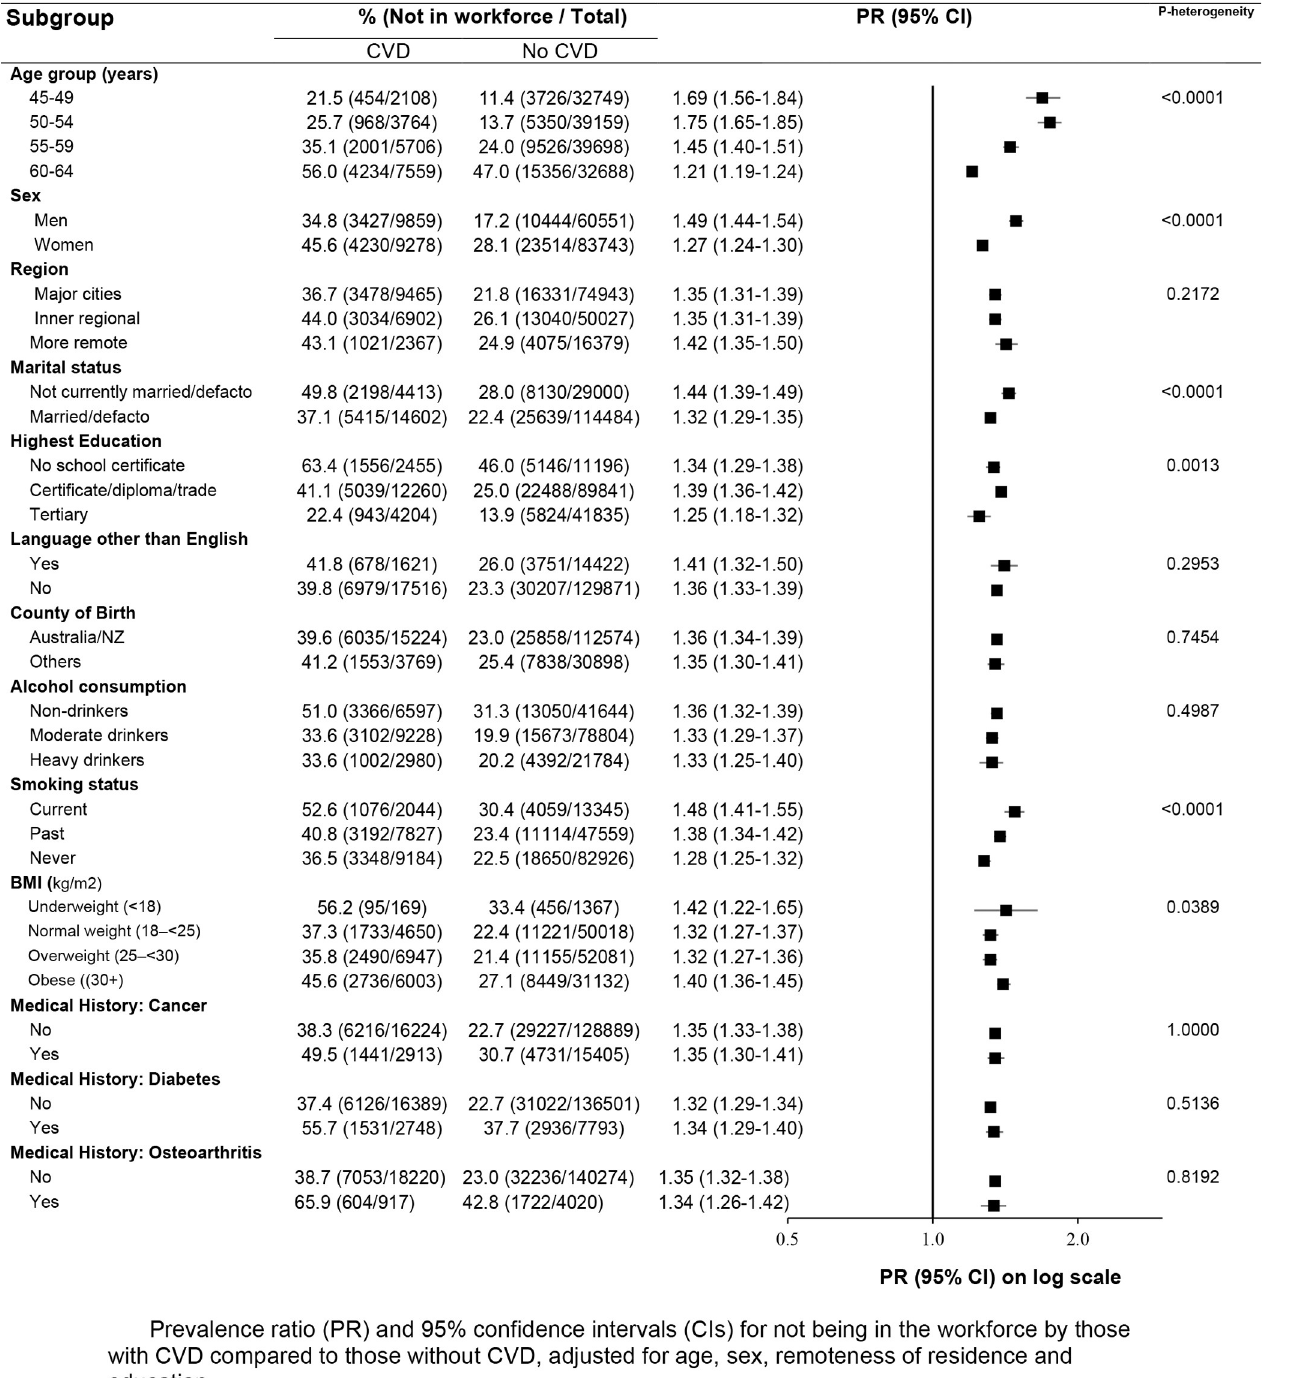
PLOS ONE | https://doi.org/10.1371/journal.pone.0249738 April 8, 2021 10 /